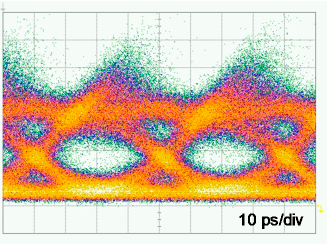
Figure 6. Eye diagram of the LEAP laser for a 25 Gbit/s NRZ signal. Bias current was 150 μ A.